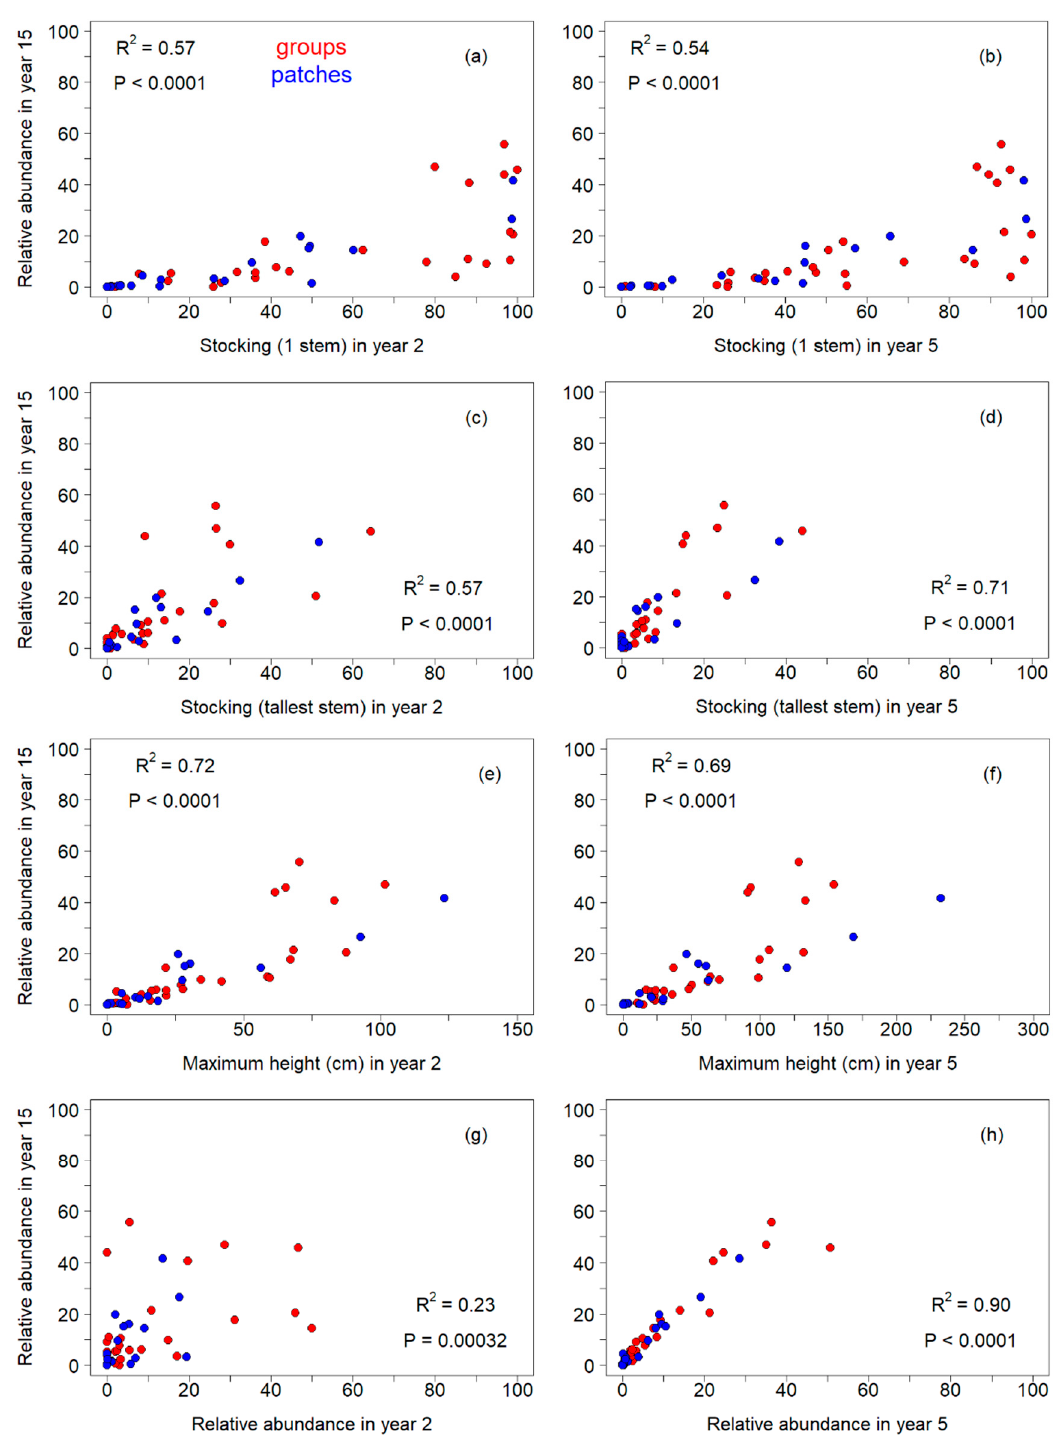
Figure 7. Relationships between relative abundance of sugar maple in year 15 and four different regeneration indices in year 2 ( a , c , e , g ) and year 5 ( b , d , f , h ), measured at the scale of 6.25-m 2 quadrats. Stockings were computed on all seedlings and saplings, while stem densities were computed on seedlings ≥ 1 m in height and saplings. Data points are cluster means. Red dots are groups, blue dots are patches. Adjusted R 2 and p -values were computed from simple linear regressions.